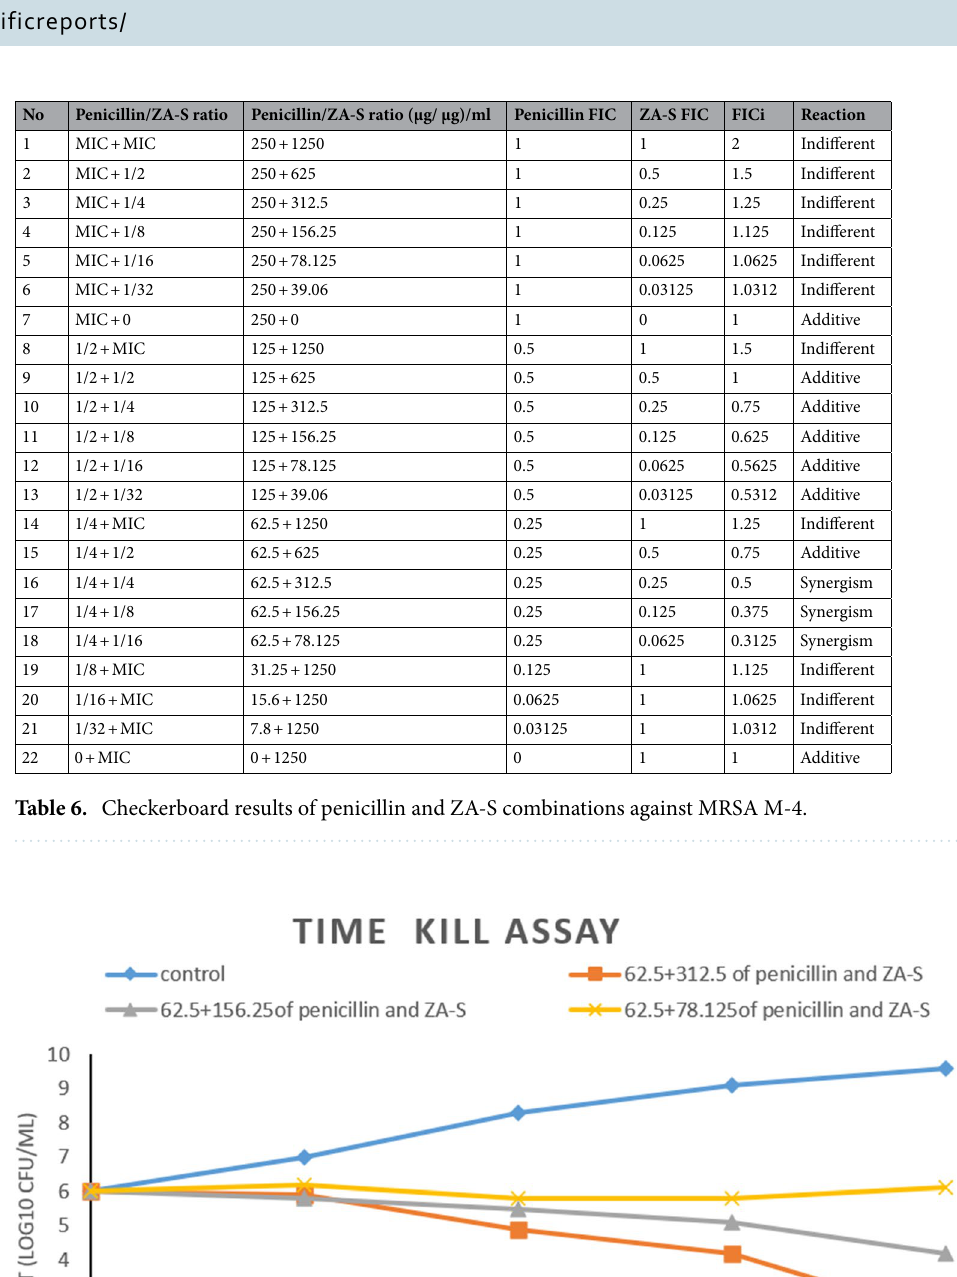
Figure 4. Time kill assay of synergistic combinations of penicillin and ZA-S against MRSA